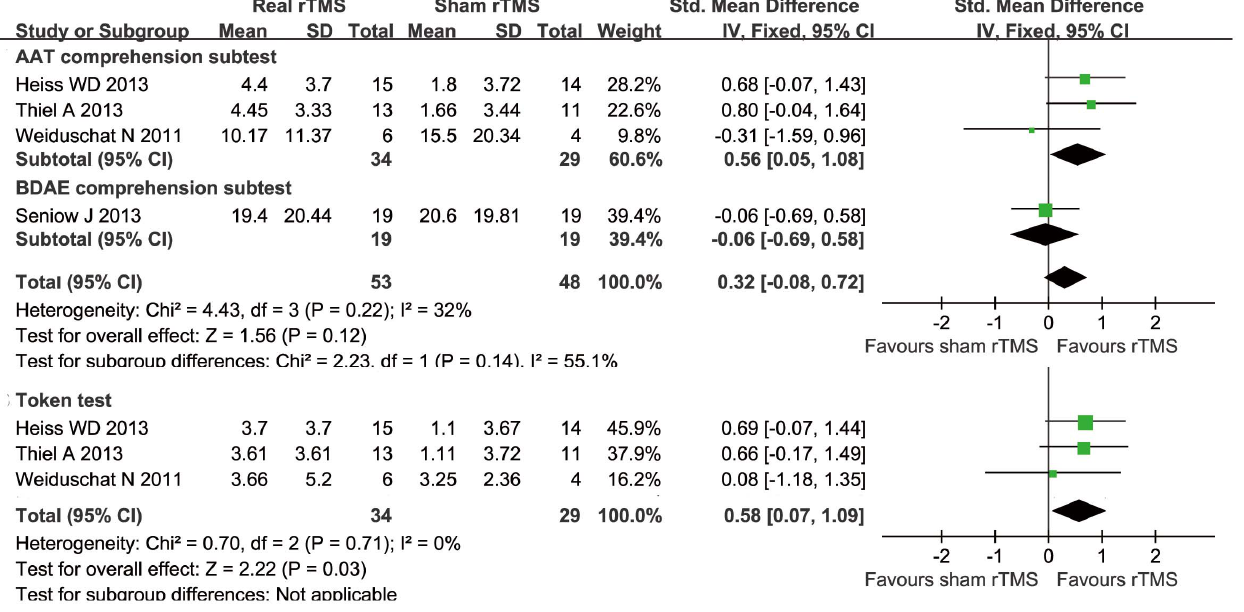
Figure 6. Forest plot of SMD and 95% CI for the outcome of comprehension in patients received rTMS and sham rTMS.